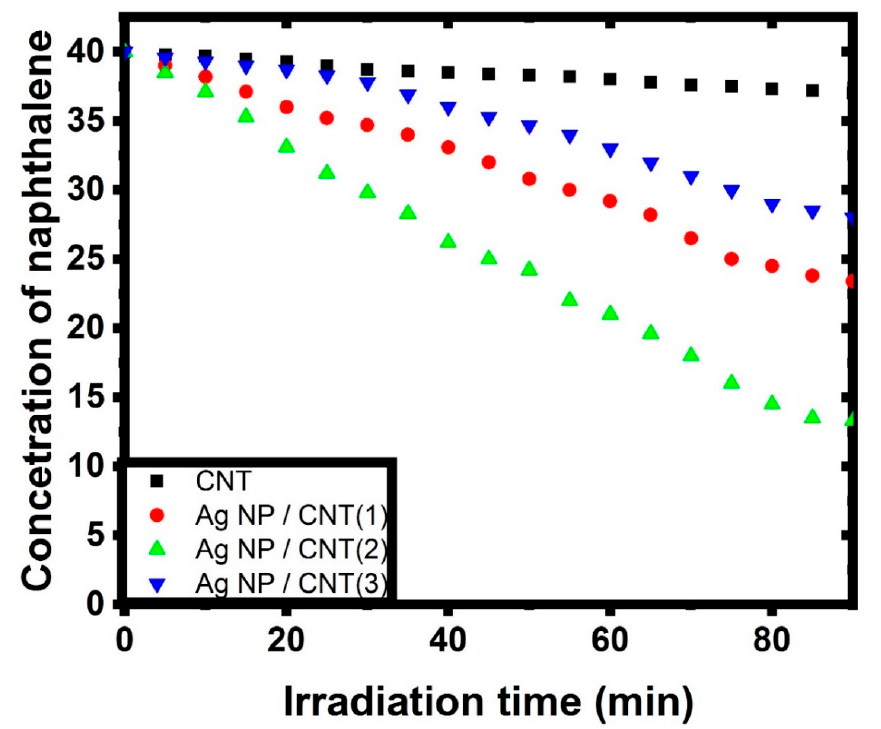
Figure 8. Decrease in naphthalene concentration with respect to different irradiations for CNTs and their decoration with different amounts of Ag NPs.